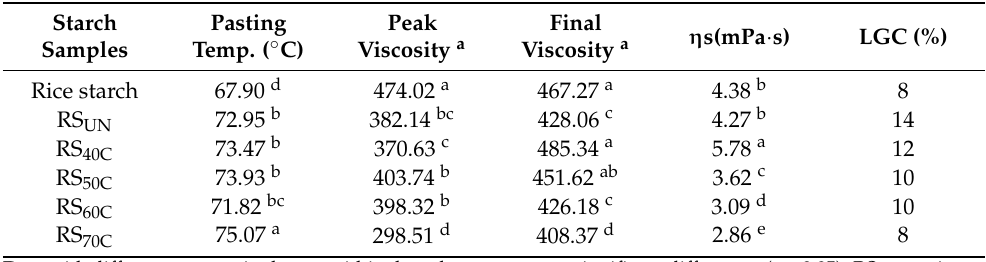
Table 3. Pasting properties and specific viscosity ( η s ) of commercial rice starch and resistant starches (RS) isolated from untreated and sonicated rice bran.